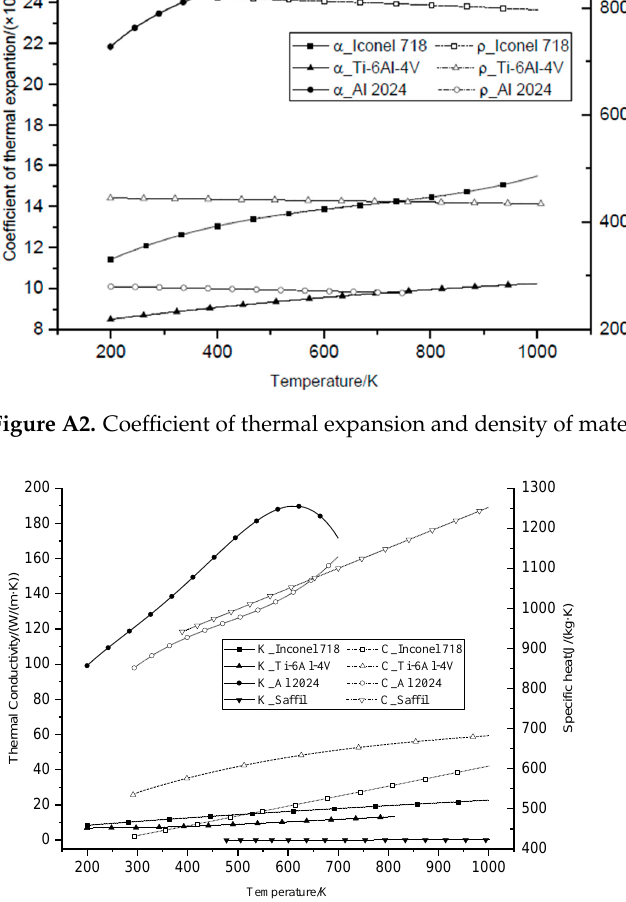
Figure A3. Thermal conductivity and specific heat of materials varying with temperature.